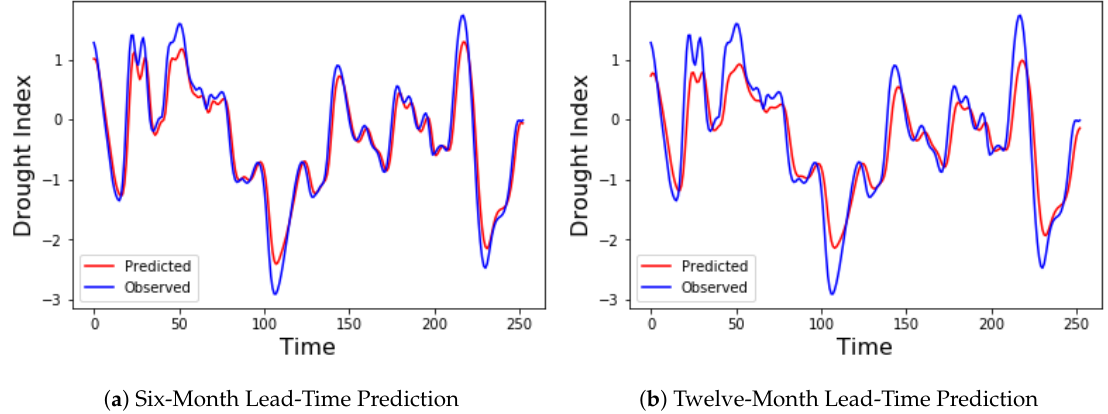
Figure 14. Observed and predicted drought index using the EMD-DBN model for Lee’s Ferry